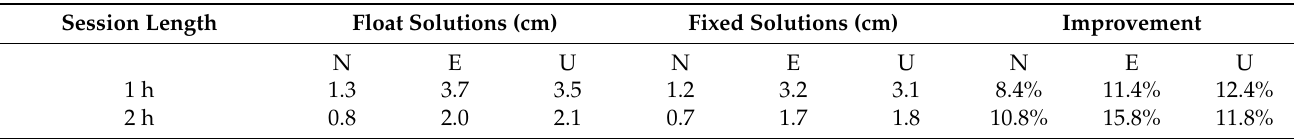
Table 2. Mean position RMS in the float and fixed 1 h/2 h hourly solutions, and the accuracy improvements after fixing the ambiguities for the 35 stations.